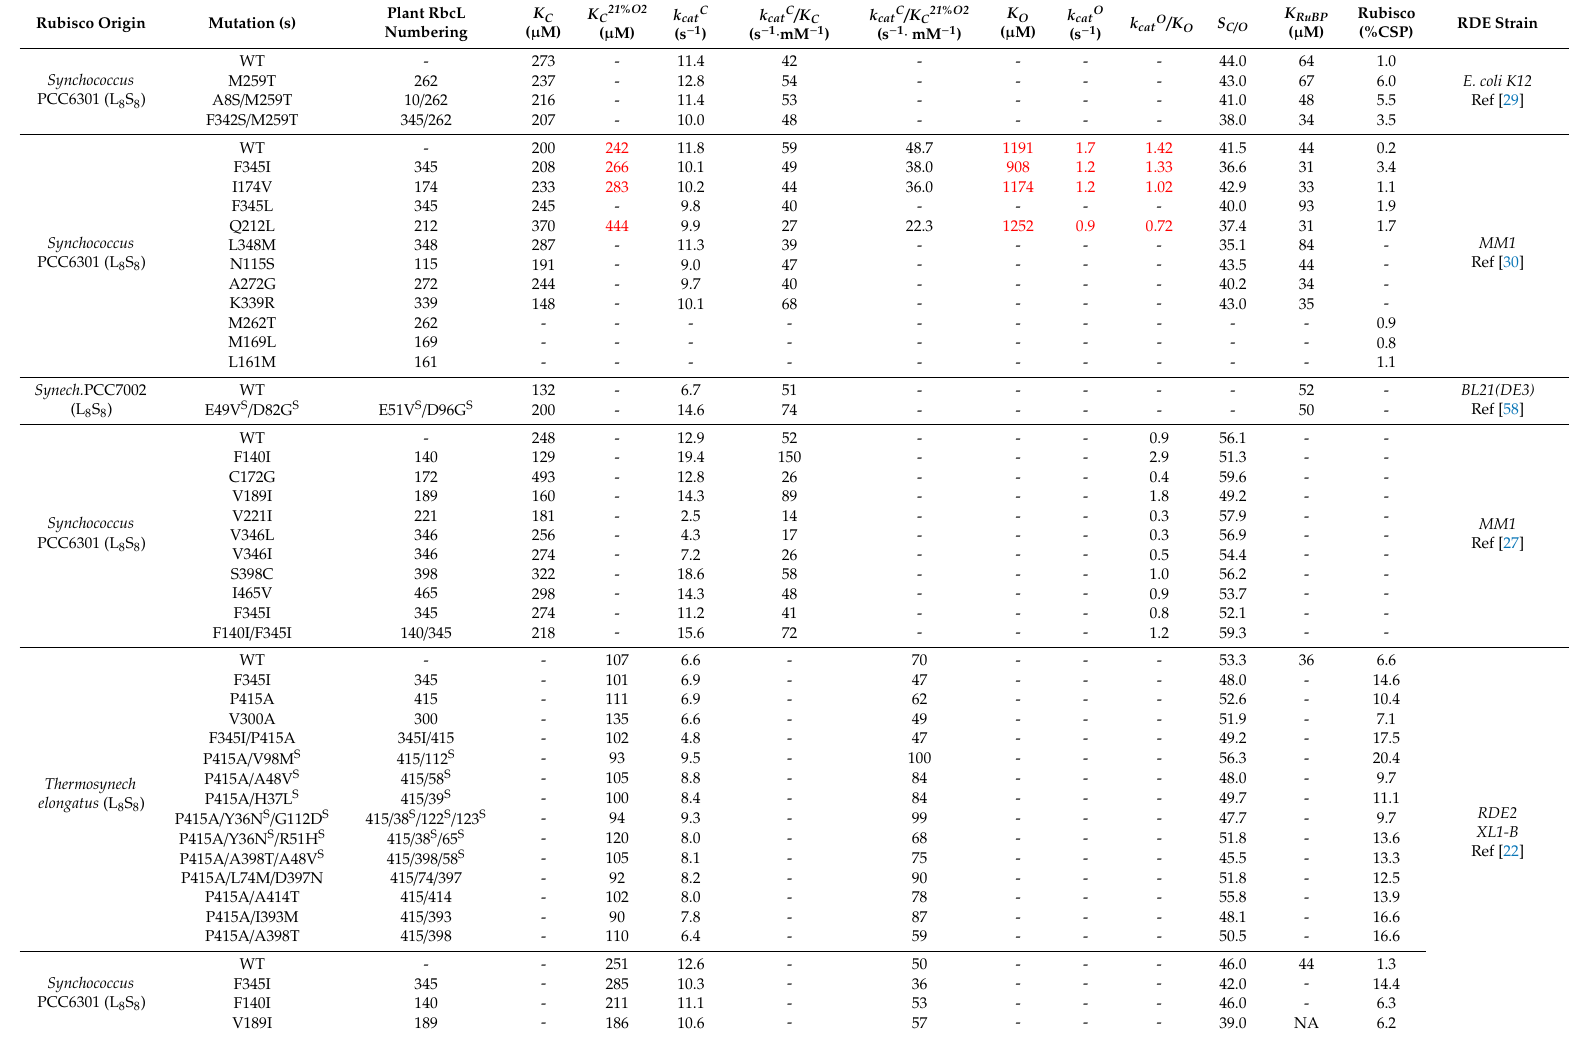
Table A1. Summary of directed evolution Rubisco mutants and the content and catalytic properties selected using E. coli and Ralstonia eutrophus screens. Rubisco